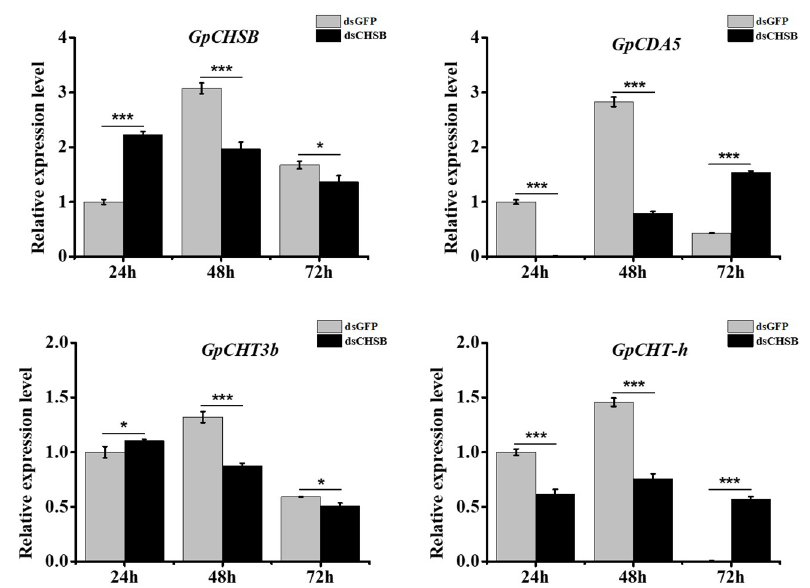
Figure 6. The analysis of expression patterns of GpCHSB and its downstream genes after injection with dsCHSB in the midgut at different times using RT-qPCR. GpRpl32 was used to normalize the data that are showed as mean ±standard error, the mean is the triple independent repeats. The 2 − △△ C t method was adopted to calculate the relative expression level. Differences among triple repeats were analyzed using one-way analysis of variance (Systat, Inc., Evanston, IL, USA) with Tukey's post-hoc test using R version 4.0.0. Asterisks represent the significant difference, as follows: * p < 0 .05; *** p < 0 .001.